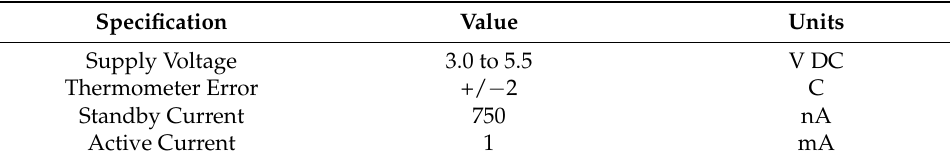
Table 4. Technical Specification of temperature sensor